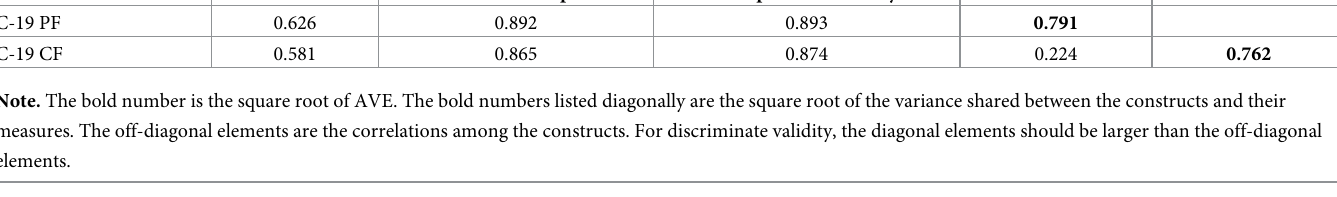
Table 6. Convergent and discriminant validity CB-SEM. Dimensions